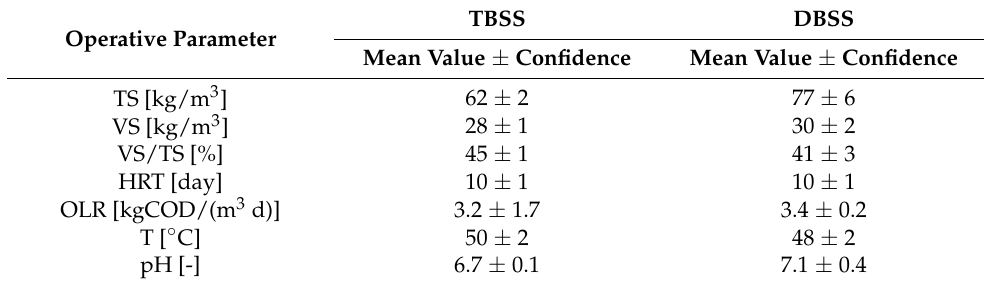
Table 2. Operative conditions in the thermophilic reactor with TBSS and DBSS. Operative